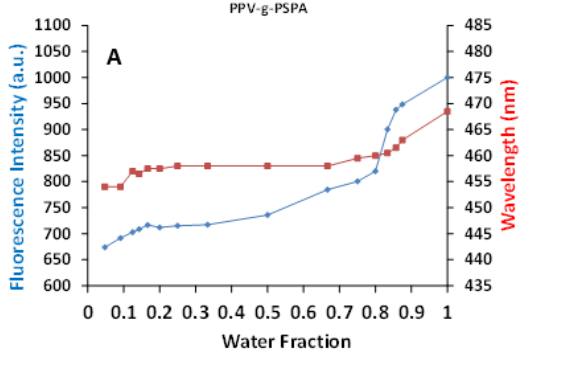
Figure 5. Fluorescence intensity and corresponding fluorescence maximum wavelength shifts for the anionic (PSPA) grafted PPVs ( A ) and PPEs ( B ) with shifting volume fraction of water in methanol.